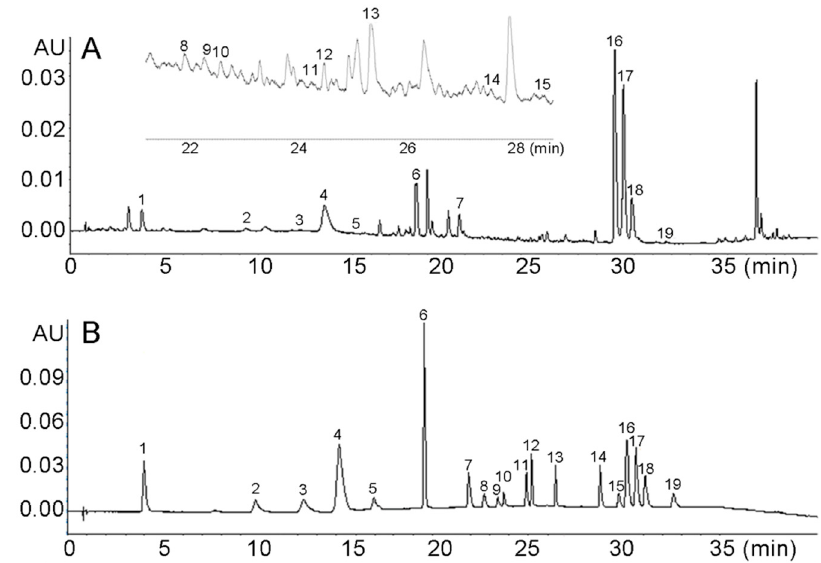
Figure 1. UHPLC chromatograms of Notopterygii rhizoma and radix sample ( A ) and standards ( B ) of